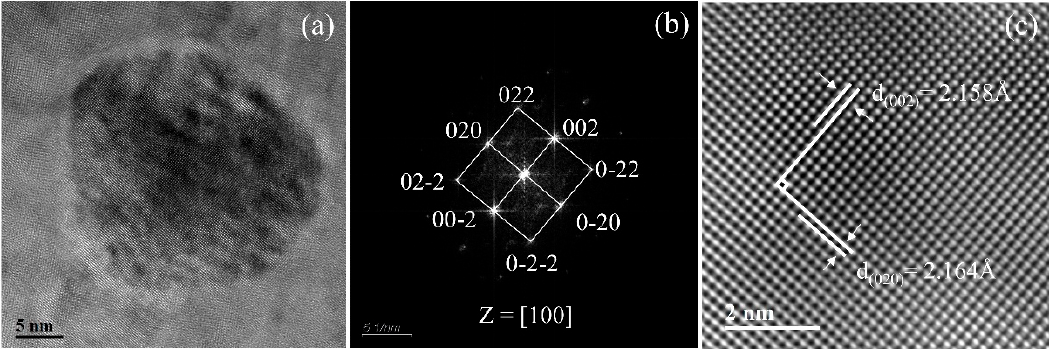
Figure 5. HRTEM images of Ti microalloyed steel deformed at 900 °C and held for 500 s: ( a ) a carbide particle; ( b ) its FFT diffractogram; and ( c ) its IFFT lattice image, with a measured lattice spacing between the two arrows.